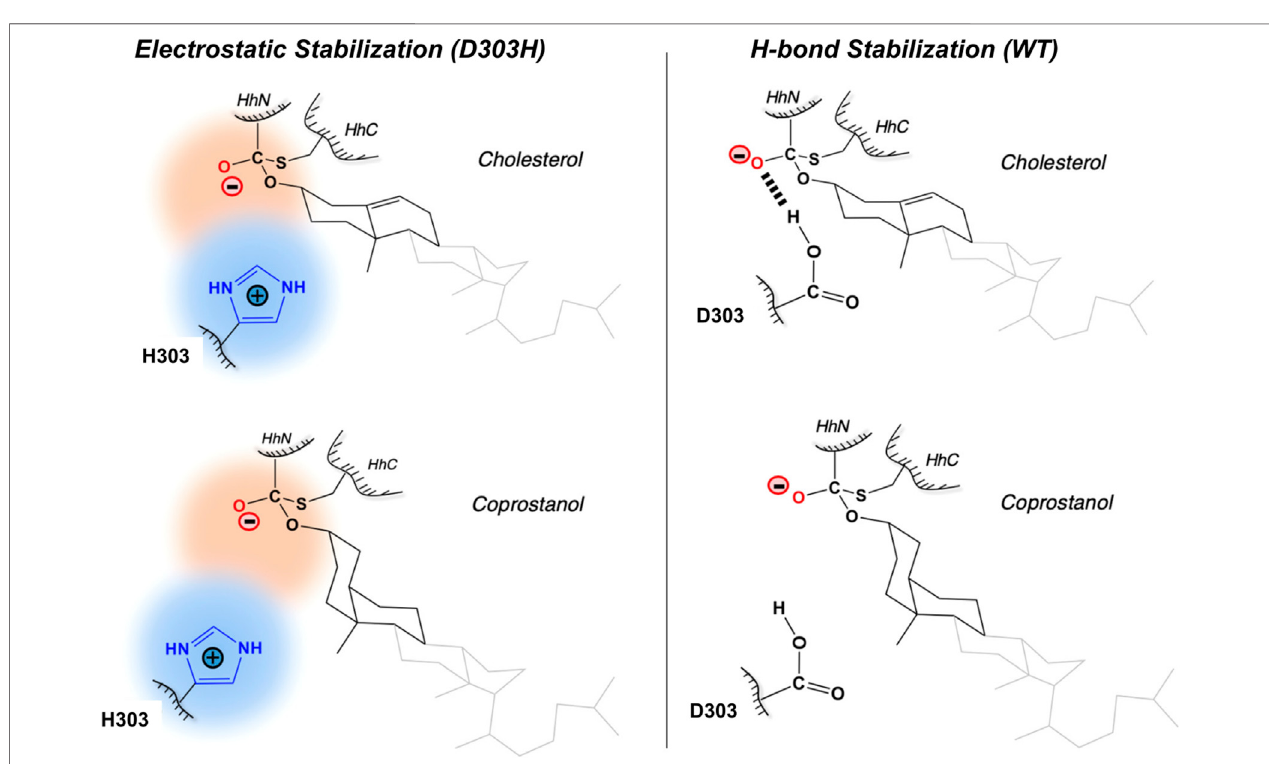
FIGURE 7 | Electrostatic stabilization mechanism by H303. Mechanism of electrostatic stabilization by H303 sidechain not available in D303. H303 promotes formationofthenegativelychargedtetrahedraladditionintermediatethroughfavorableelectrostaticinteractionwithitssidechainimidazolium.Figurefromthereference, Zhao et al. (2019) with